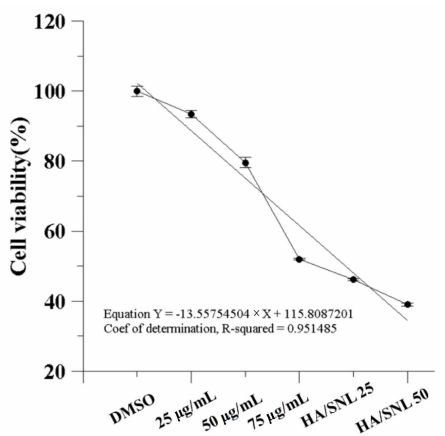
Figure 4. Effect of SNL and HA/SNL aggregates on A549 cell viability. Cell viability remained 50% (IC 50 ) when treated with 75 µ g/mL pure